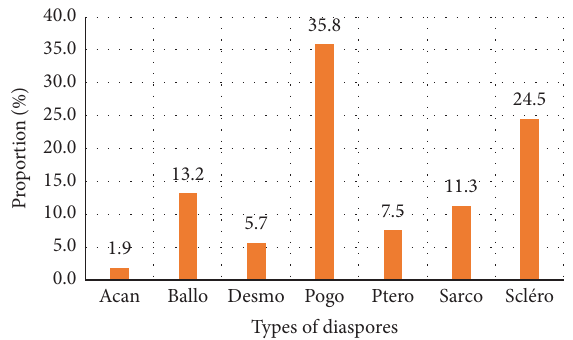
Figure 10: Proportion of diaspores types: (Acan) Acanthochores, (Ballo) Ballochores, (Desmo) Desmochores, (Pogo) Pogonochores,